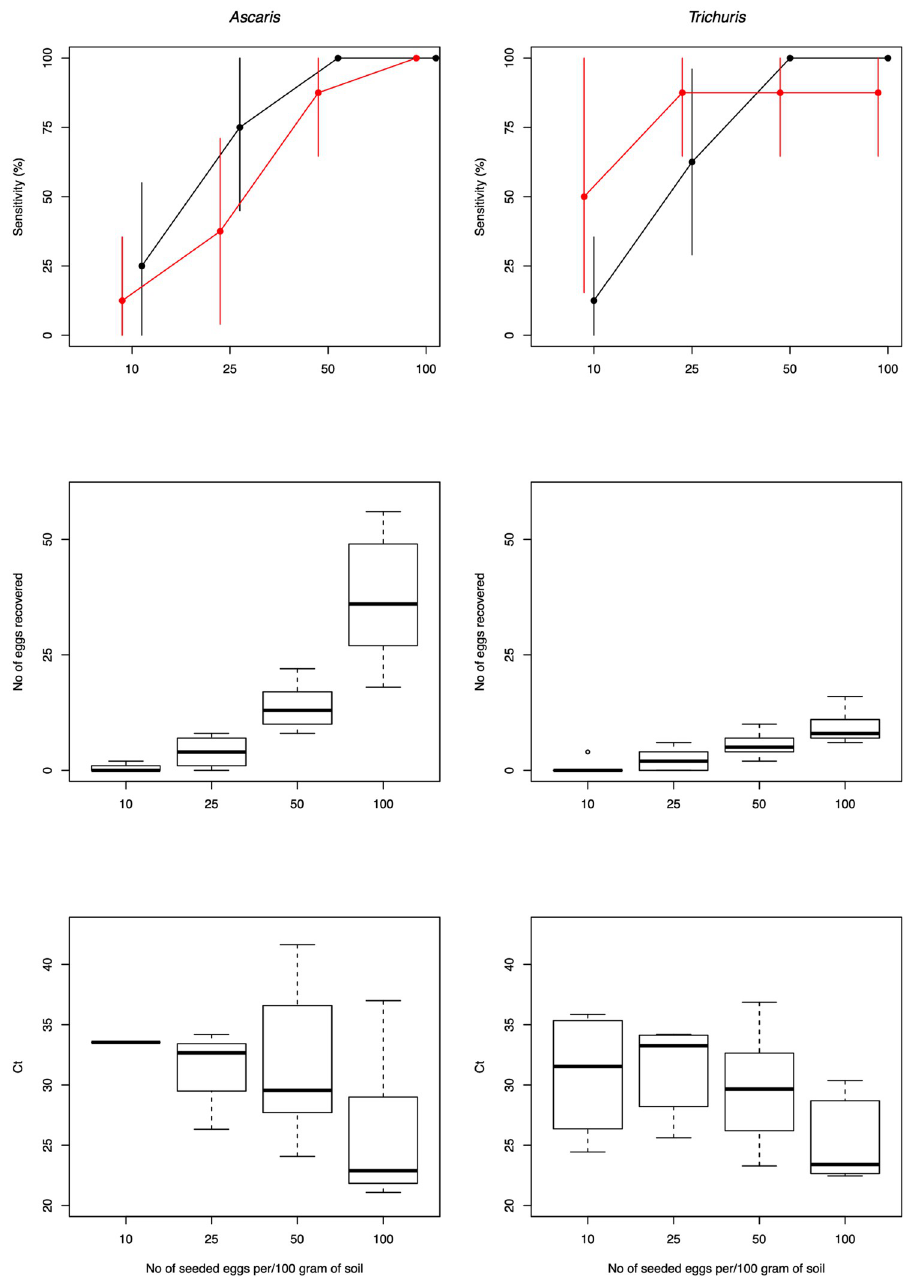
Fig 3. The diagnostic performance of the optimized straining-flotation method to detect and quantify Ascaris and Trichuris eggs in soil. The panels describe the sensitivity for both microscopy and qPCR ( top row panels ), the egg recovery rate for microscopy ( middle row panels ) and the Ct-values for qPCR ( bottom row panels ) separately for Ascaris ( left column panels ) and Trichuris ( right column panels